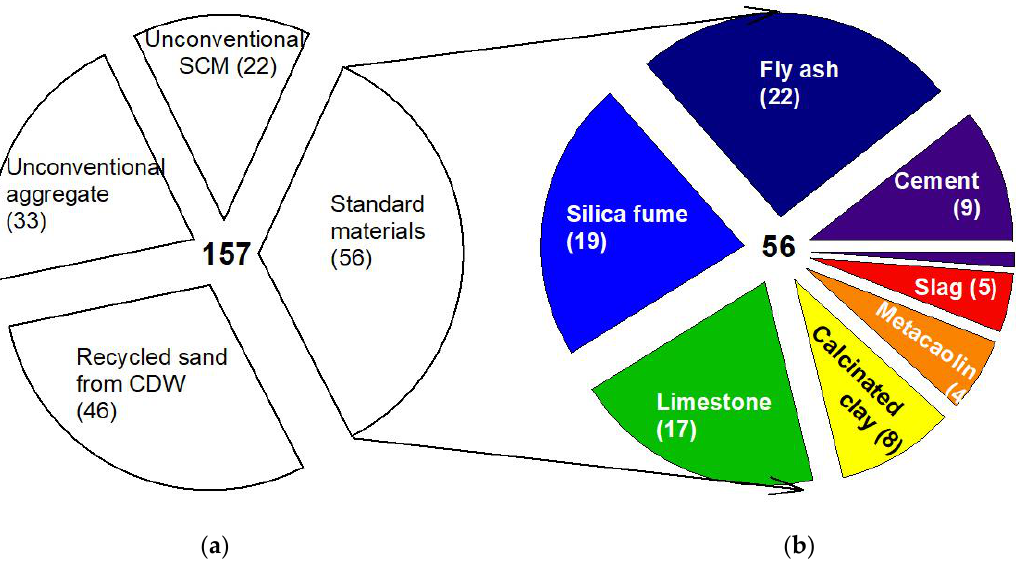
Figure 7. ( a ) 3DPCC constituent materials sources overview; ( b ) 3DPCC standard materials used as binder constituents.